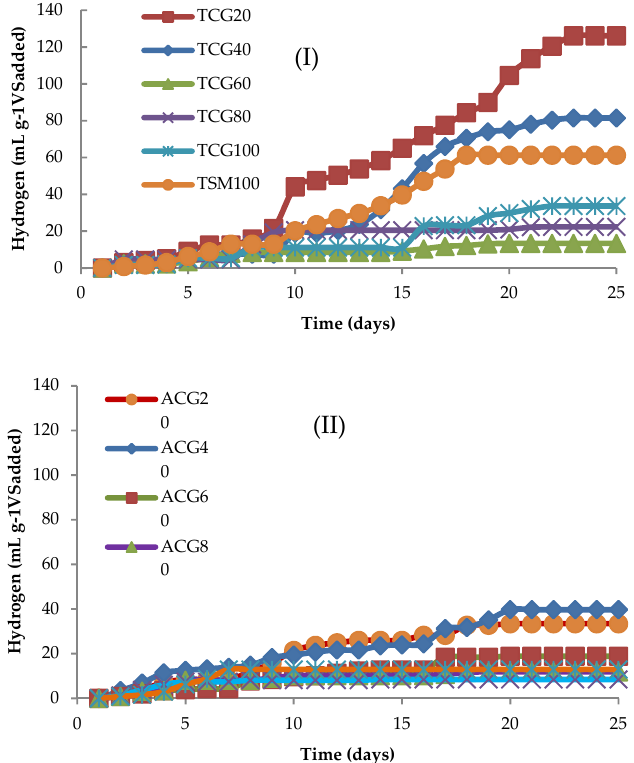
Figure 1. Comparison of the kinetics of hydrogen production with ( I ) thermal pretreated inoculum (T) and ( II ) acid pretreated inoculum (A). In assays were added different concentrations of substrates: CG20 (20% CG:80% SM), CG40 (40% CG:60% SM), CG60 (60% CG:40% SM), CG 80 (80% CG:20% SM), CG100 (100% CG), SM100 (100% SM).